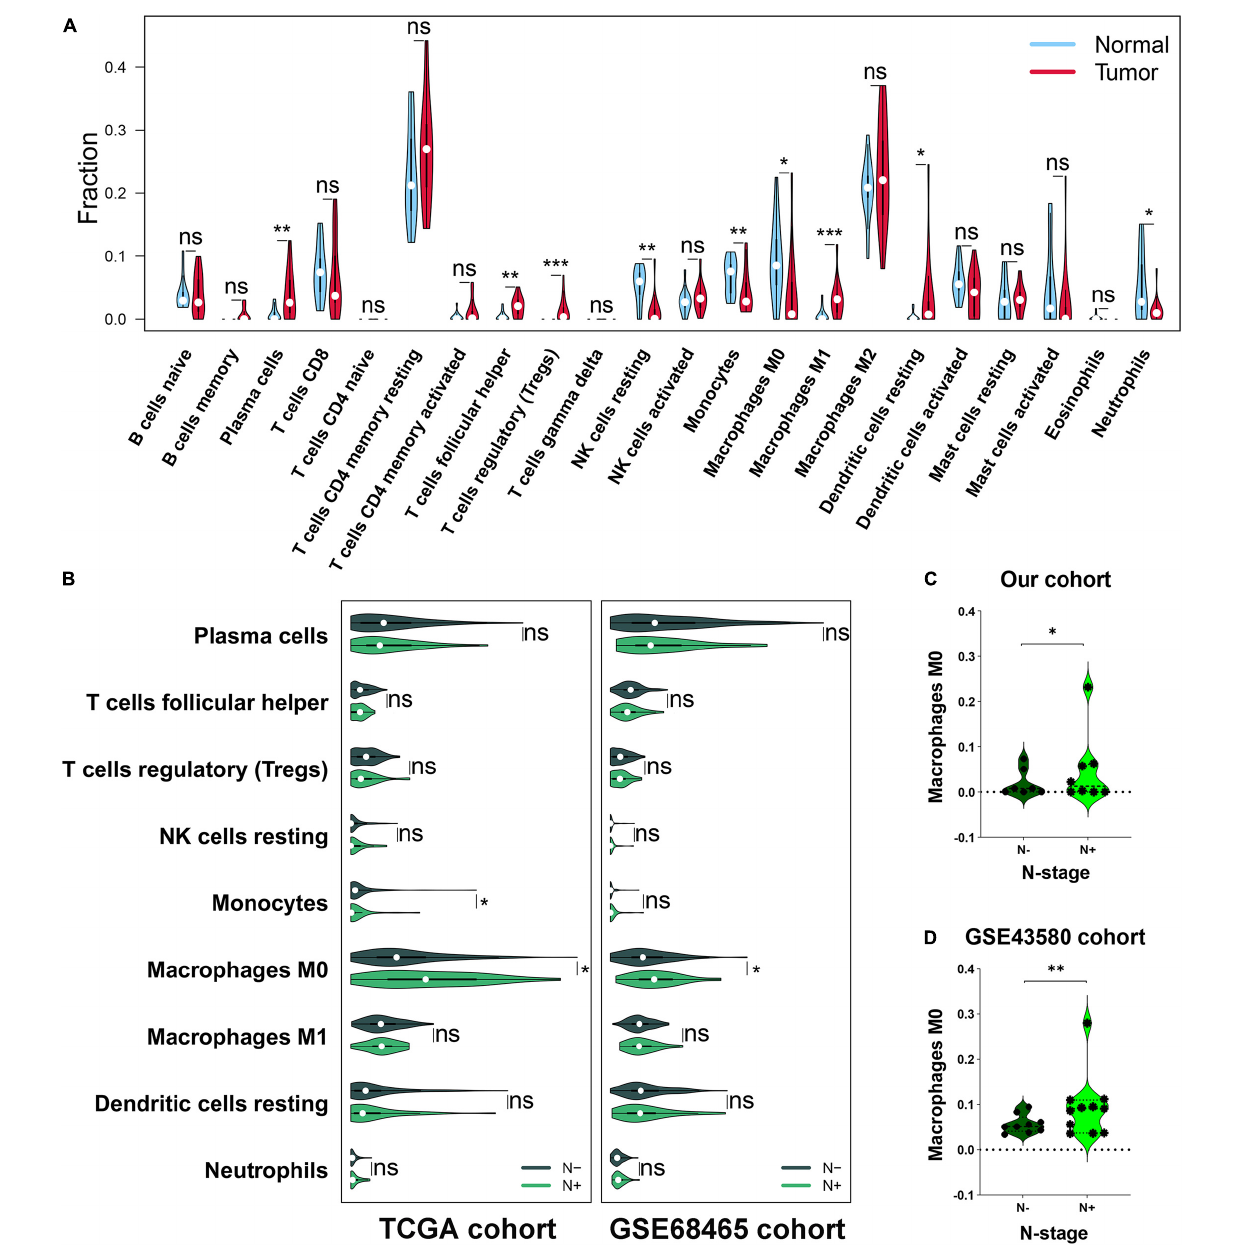
FIGURE 1 | Analysis of the immune cell infiltration abundance in Stage-T1 lung adenocarcinoma (LUAD). (A) Comparison of the infiltration levels of 22 immune cells in tumor tissues versus adjacent lung tissues. (B) Comparison of the infiltration abundance of nine immune cell types in the lymph node metastasis group versus the non-metastasis group of TCGA and GSE68465 cohorts. In our cohort (C) and the GSE43580 cohort (D) , a higher M0 infiltration was associated with early lymph node metastasis. ns, not significant, * p < 0.05, ** p < 0.01, and *** p < 0.001. TCGA, The Cancer Genome